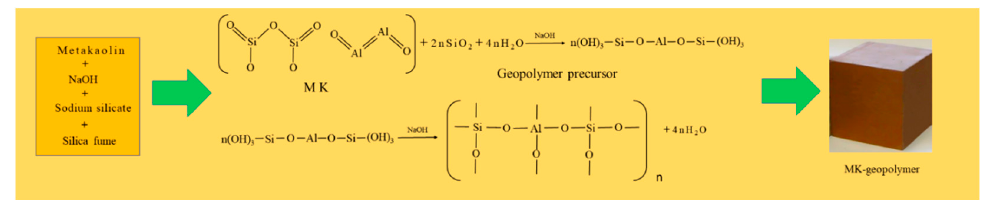
Figure 3. Diagram of geopolymer formation.